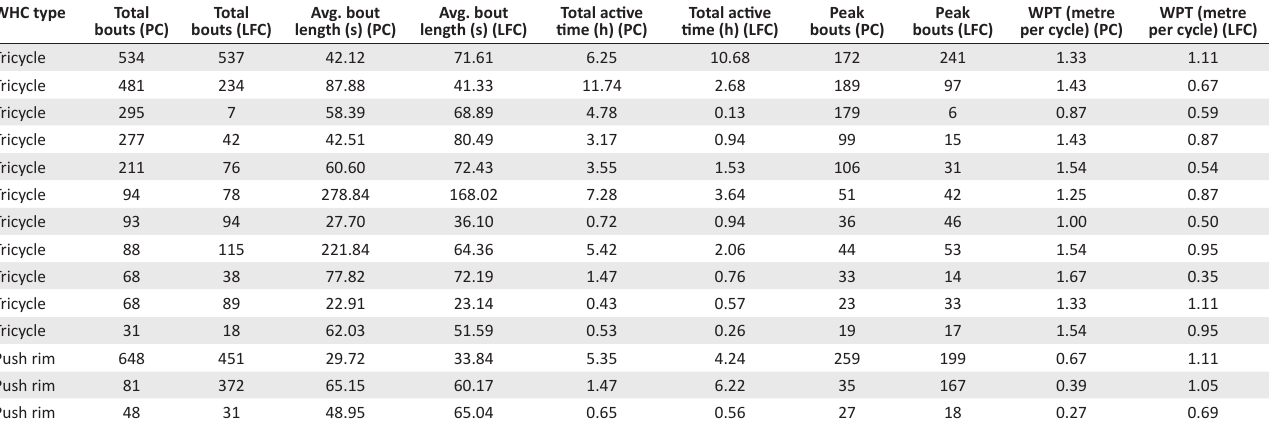
TABLE 2: Individual participant descriptive statistics for performance measures. WHC